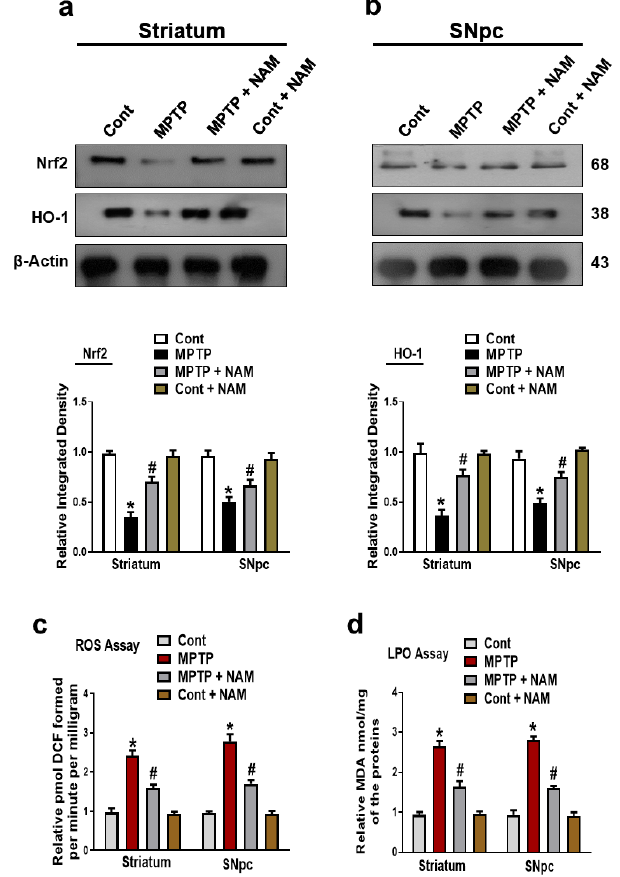
Figure 5. Nicotinamide (NAM) ameliorating oxidative stress and regulated the expression of the Nrf2 and HO-1 pathway in the Striatum and SNpc of mice. ( a , b ) Images of the scanned immunoblot results of Nrf2 and HO-1 and their graphical representation in the striatum and SNpc of the different experimental groups. β -actin was used as a loading control; ( c ) Graphical representation of the reactive oxygen species (ROS) level in the striatum and SNpc of the different experimental groups; ( d ) Graphical representation of the results of the lipid peroxidation (LPO) assay in the different experimental groups. The values are expressed as the mean ± SD for indicated proteins ( n = 10 mice/group), and the number of independent experiments was n = 3. * Significantly different from the control group, # Significantly different from the MPTP-treated group. Significance: * p < 0.05; # p < 0.05.